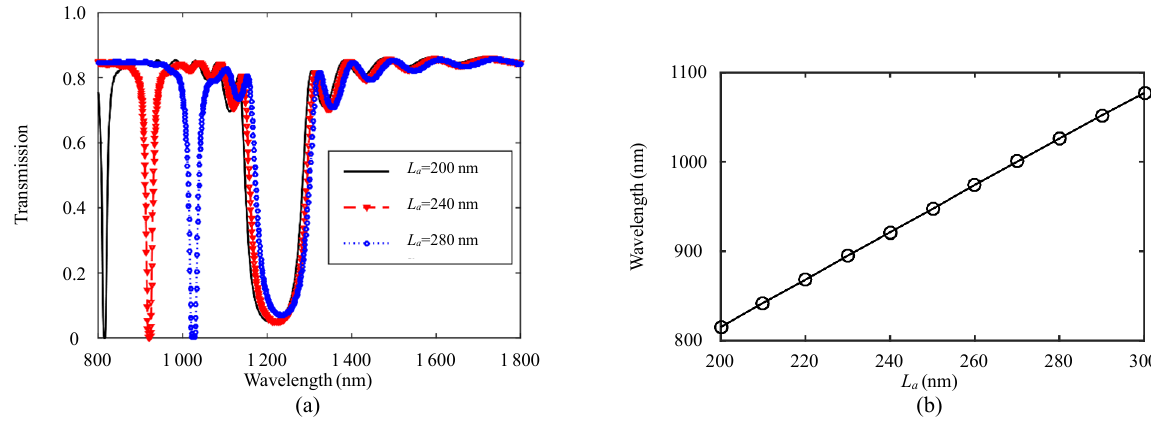
Fig. 6 Transmission spectra and MZI wavelength under different conditions: (a) transmission spectra by setting L u = 50 nm, L d = 70 nm and L a = 200 nm, 240 nm, and 280 nm, respectively and (b) MZI wavelength with respect to the variation of L a